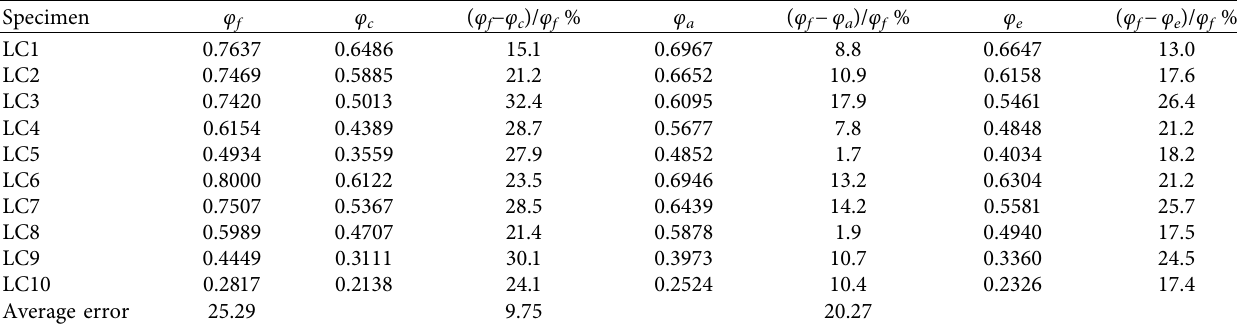
Table 6: Comparison between the test results and the results obtained by Chinese, US, and European codes.